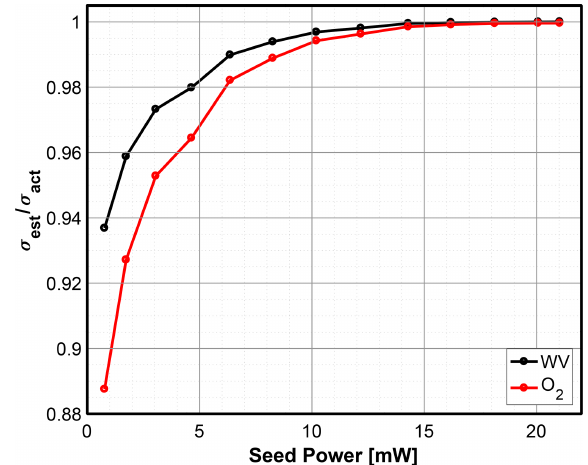
Figure 8. Spectral purity of fiber-coupled seed laser and free-space TSOA for a range of drive currents and seed powers. TSOA op- erated at 8kHz for a duration of 0.625µs. The spectral purity was defined as the amount of power in the center ± 100MHz divided by the remaining 1.8GHz band.